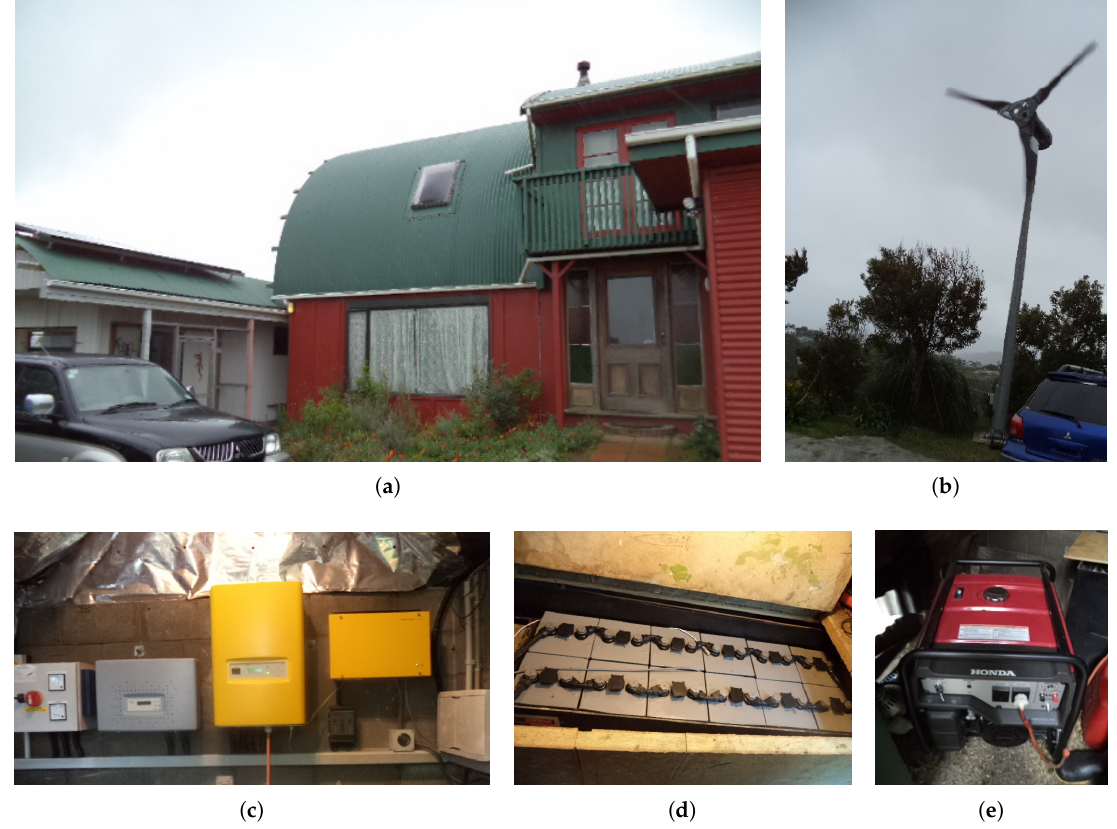
Figure 2. An example of a wind-based microgrid deployed for an off-grid house in Brooklyn, Wellington, New Zealand. ( a ) PV system on the roof of a house; ( b ) Wind turbine; ( c ) Rectifier, controllers and distribution board; ( d ) Battery bank; ( e )